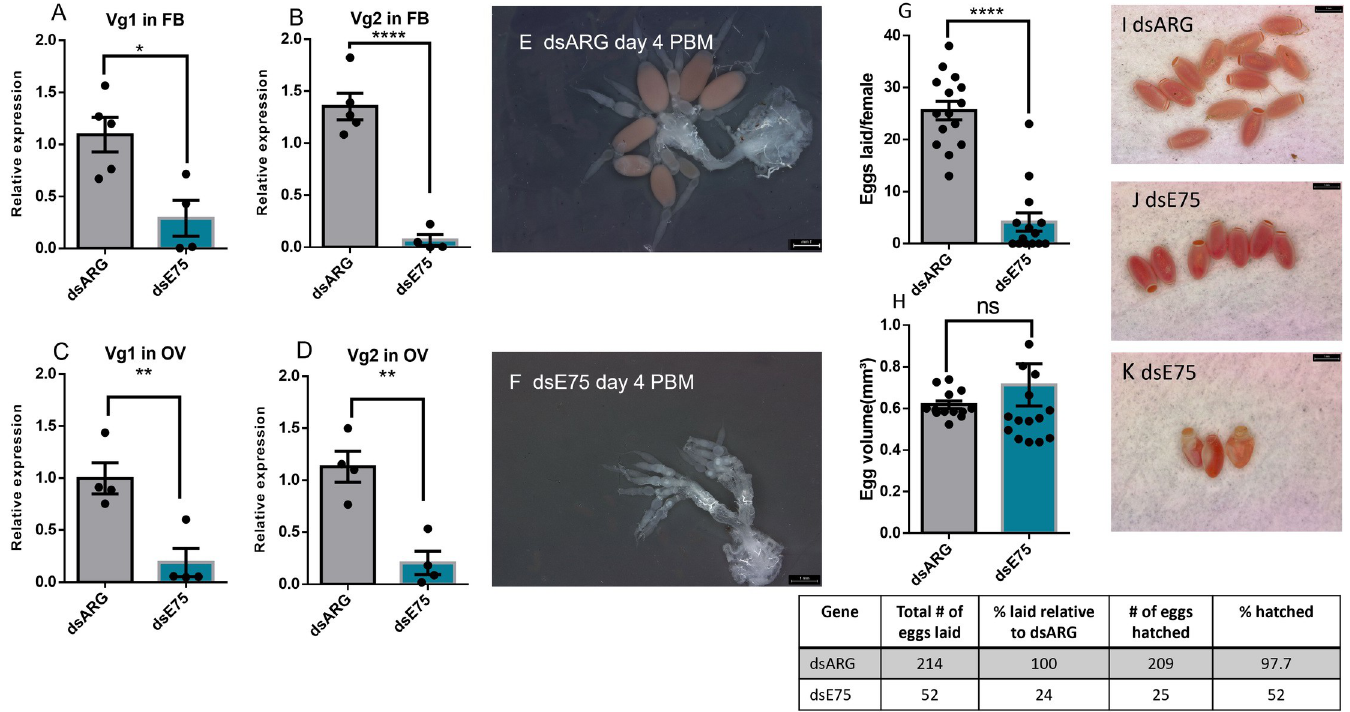
Fig 8. Effect of knockdown of E75 mRNA in adult females on egg production. RT-qPCR was used to quantify the relative transcript levels of Vg1 and Vg2 in the fat body (FB) and the ovary (OV) at 4 d post blood meal (PBM) in dsARG (control) and dsE75-injected females. Vg1 in FB (A), Vg2 in FB (B), Vg1 in ovary (C), and Vg2 in ovary (D). dsE75-injection affects ovarian phenotype in comparison to dsARG-injected controls (E and F) (n = 4). Eggs laid per female over 15 days PBM (G) (n = 15) and egg volume (H) (n = 15). Phenotypes of laid eggs from insects injected with dsARG (I) or injected with dsE75 (J and K) (n = 15). At 4 days PBM, ovaries were dissected, and images were taken. Rp49 and β -actin were used as reference genes. The transcript levels were quantified using RT-qPCR and analyzed using the 2 − ΔΔ Ct method. Results are presented as mean ± SEM. Student’s t-test was used for statistical analysis. � p < 0.05; �� p < 0.01, ���� p < 0. 0001, ns = not significant.